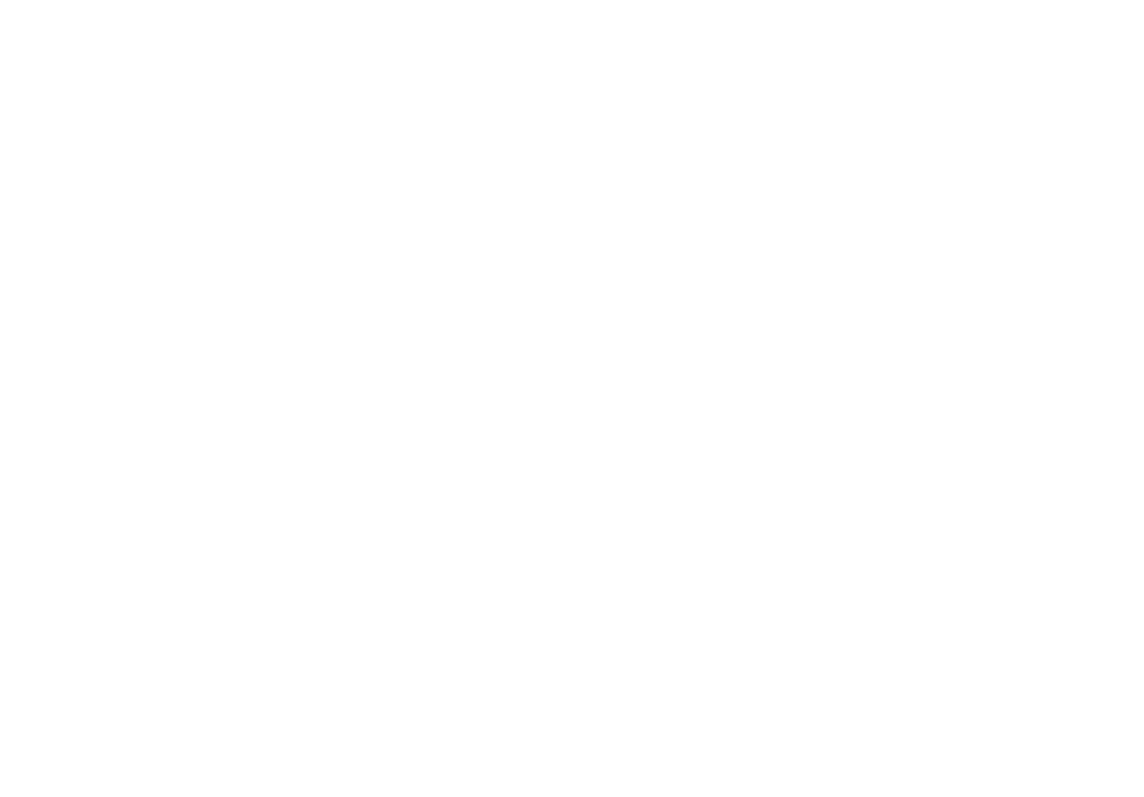
Figure 15. Effect of the roller number on the run-out variation of the inner